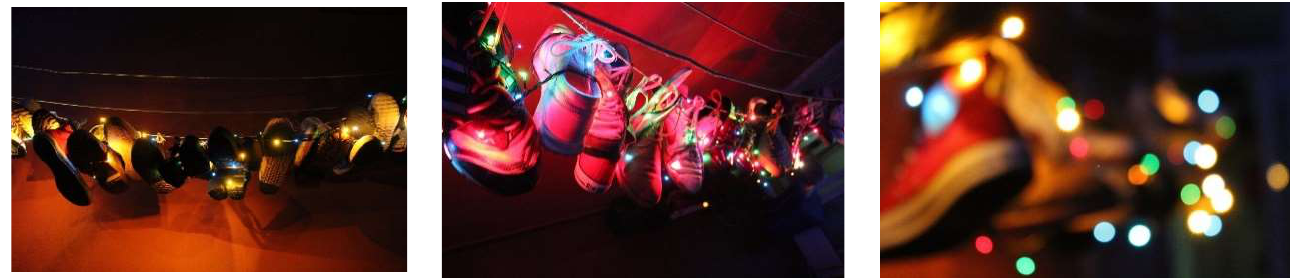
Figure 5. Evocation of Light. Photographic series